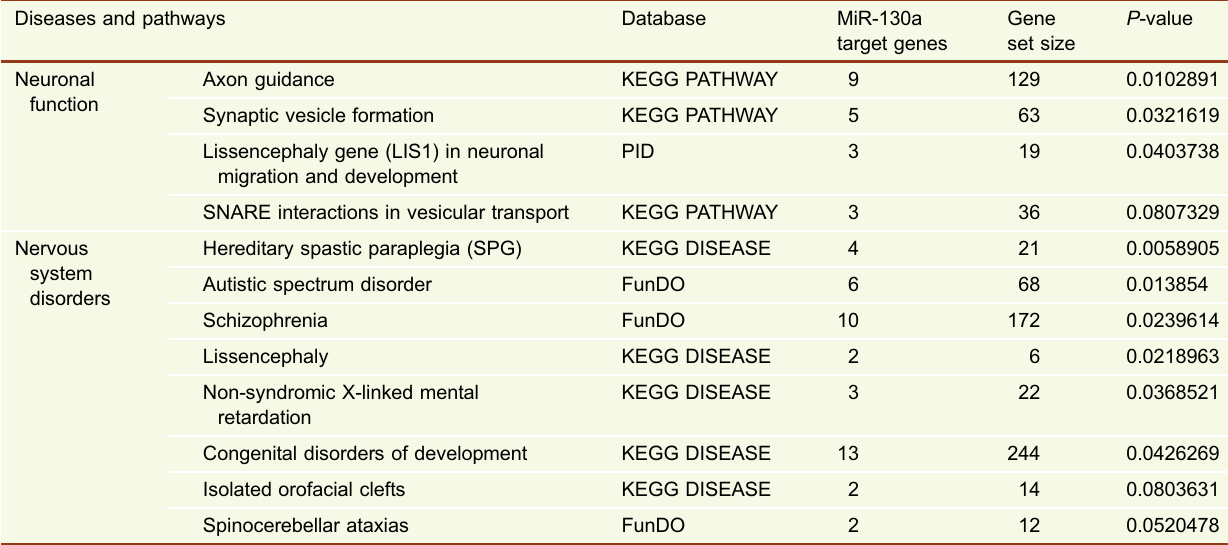
Table 1. Candidate target protein-coding genes for miR-130a Diseases and